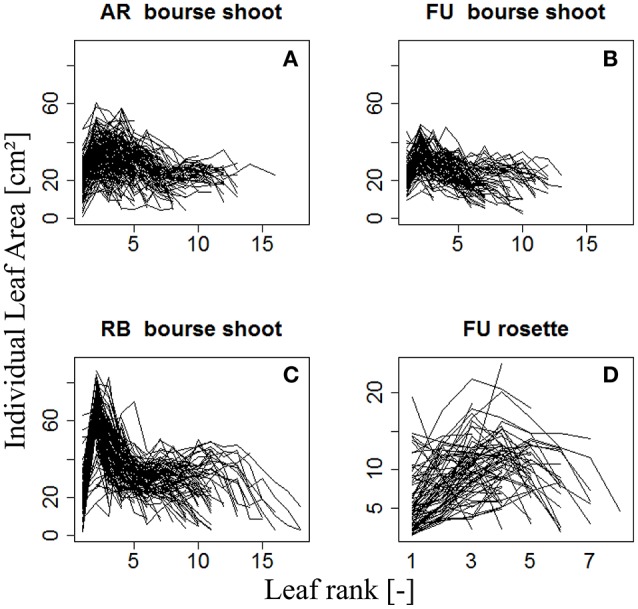
Distribution of individual leaf area as a function of leaf rank of AR, FU, and RB bourse shoots (N = 153, 97, and 112, respectively) (A–C) and of FU rosettes (N = 80) (D). Each line joins the individual leaf areas of a single shoot.